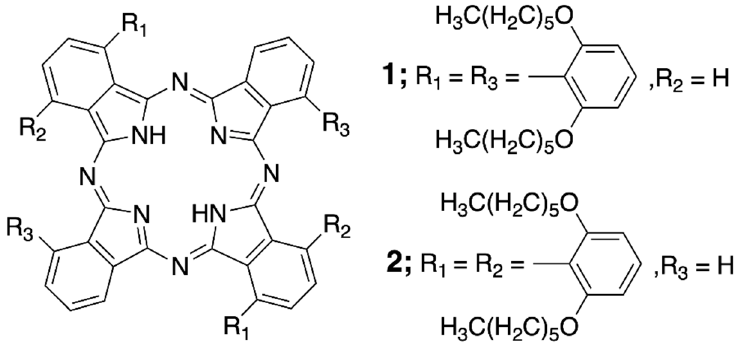
Figure 1. Chemical structures of 1 and 2 .